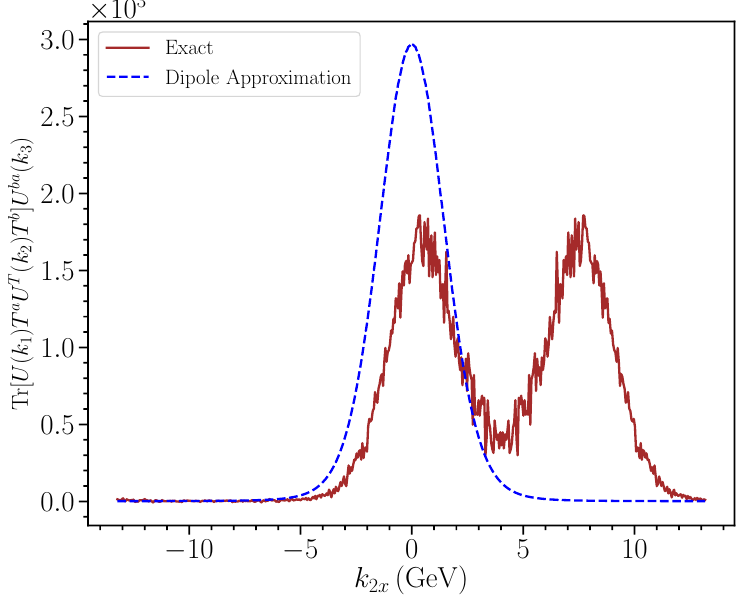
Figure 4. Dipole approximation gives incorrect prediction for the three-Wilson-line